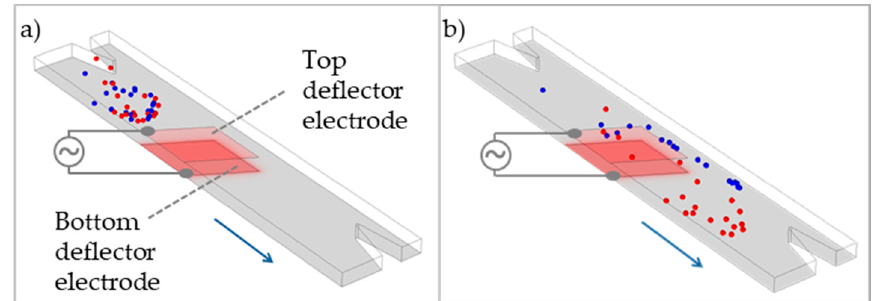
Figure 2. Simulation of dielectrophoresis (DEP) cell separation in a microfluidic flow. ( a ) before and ( b ) after microalgae Chlamydomonas reinhardtii have passed a deflector electrode configuration (top and bottom electrode).